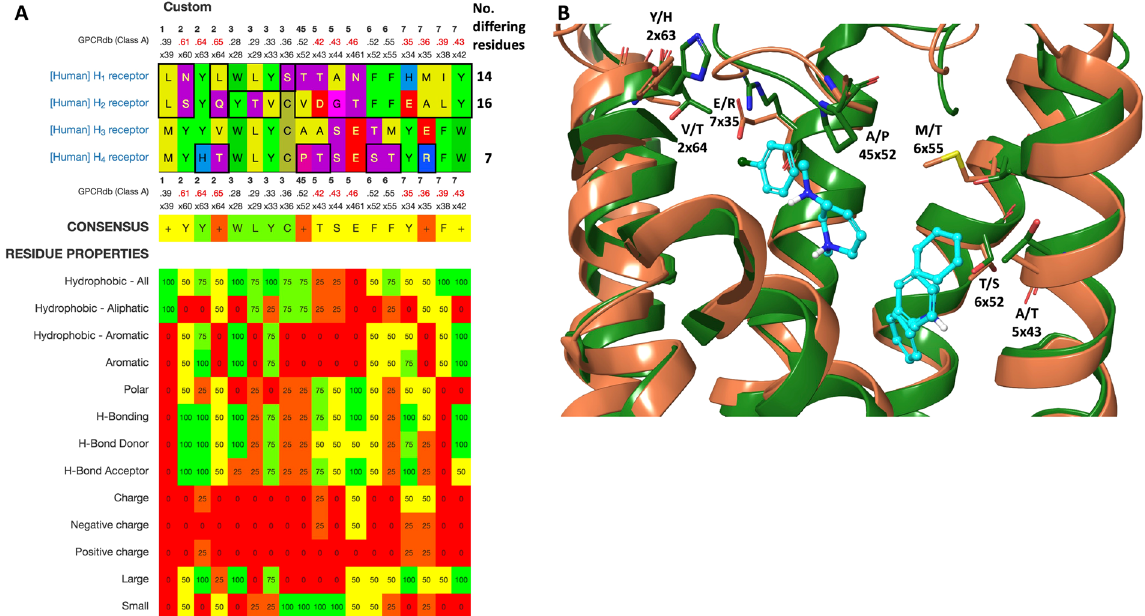
Figure 5. Histamine receptor subtype selectivity hotspots. ( A ) Sequence alignment of the non-conserved histamine receptor binding cavity residues that offer the most viable contact points for achieving subtype- selective ligands. Below the consensus sequence is shown also the residue properties, which when unique for the target may guide the choice of ligand substitution. ( B ) Superposition of the H3 target (brown) with the most homologous receptor, H4 (green). Pharmacophore fragments are displayed as balls and sticks (cyano) and selectivity hotspot residues as